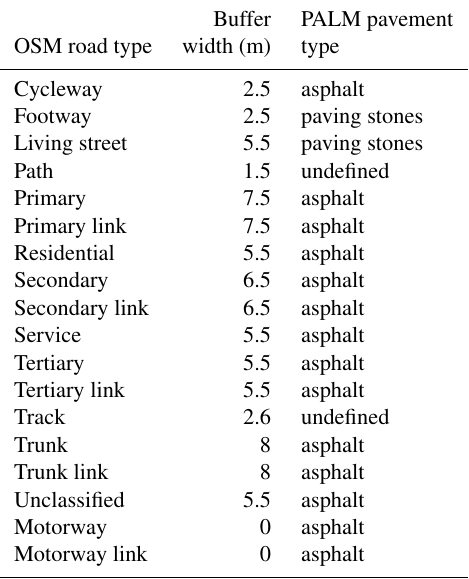
Table B5. OSM road types and corresponding PALM pavement type. The buffer width in this table is only used to convert the line objects into areas if no value is indicated for street width in the OSM data. If the number of lanes is indicated, the street width listed in Table B6 is applied.